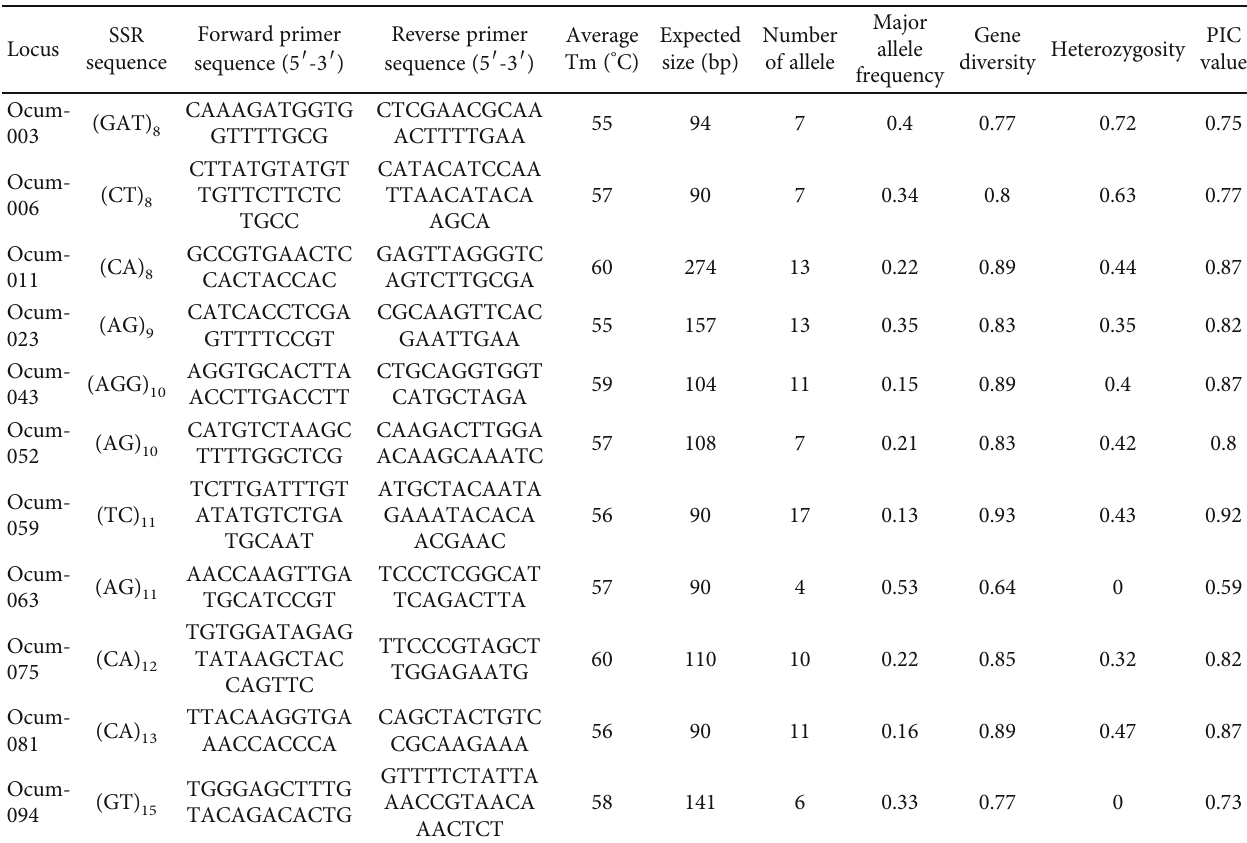
Table 1: List of transferred SSR markers used to test 96 O. crenata samples with major allele frequency, number of alleles, gene diversity, heterozygosity, and PIC values.